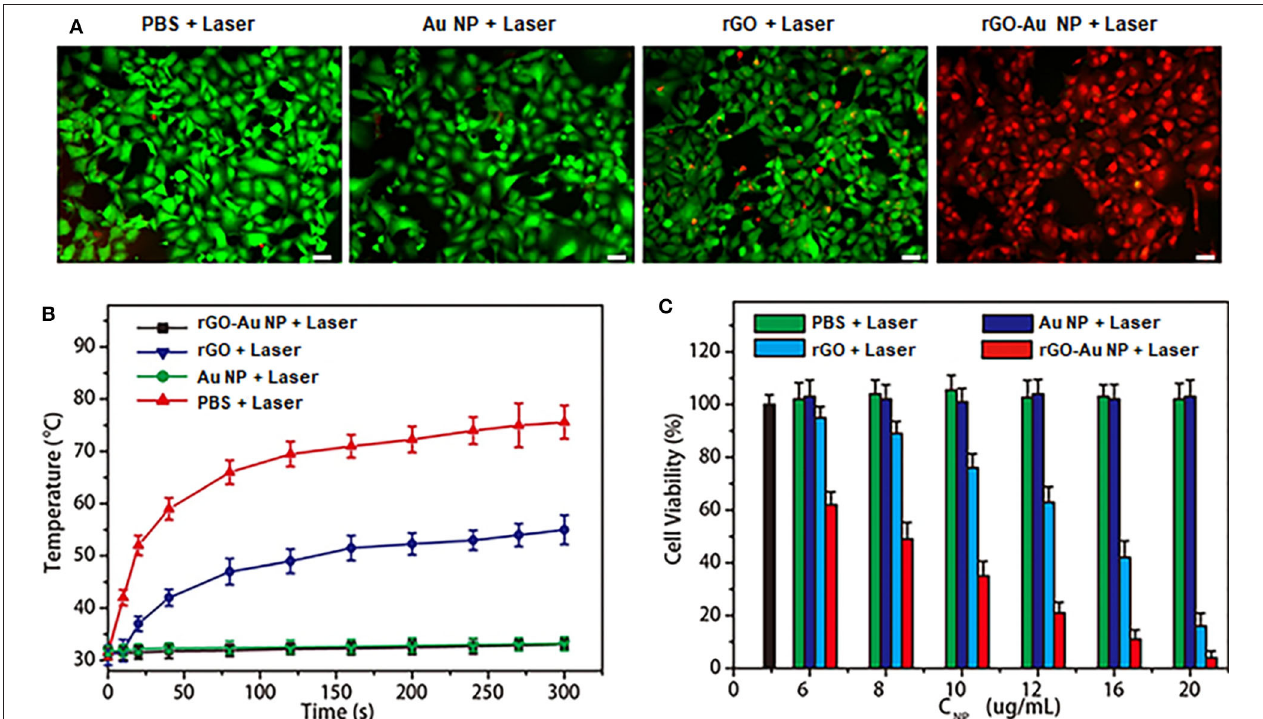
FIGURE 3 | In vitro photothermal therapy with tumor cells. (A) The fluorescence images of SKOV-3 cells treated with rGO and AuNPs and rGO-AuNP for 24h before a 1,061nm laser irradiation applied (0.25 W/cm 2 , 300s). PBS only as a blank control. (Green fluorescence: Calcein AM, red fluorescence: PI. Scale bar: 20 µ m). (B) Temperature curves of SKOV-3 cancer cells treated with PBS, rGO, AuNPs, and rGO-AuNP in aqueous solutions irradiated with a 1,061nm laser as a function of time. (C) Cell viability of SKOV-3 cancer cells treated by different nanomaterials at different concentrations and PBS with and without 1,061nm laser irradiation (Blank bar: control